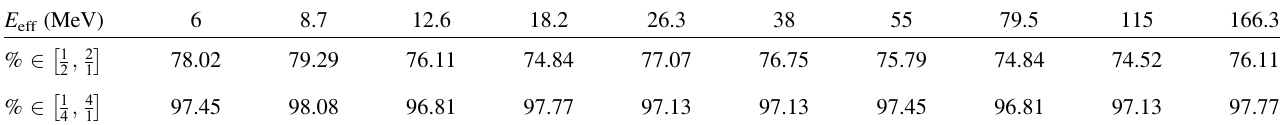
Table 4. Percentages of predictions within a factor of 2 and 4 of the data with the FORSPEF list.